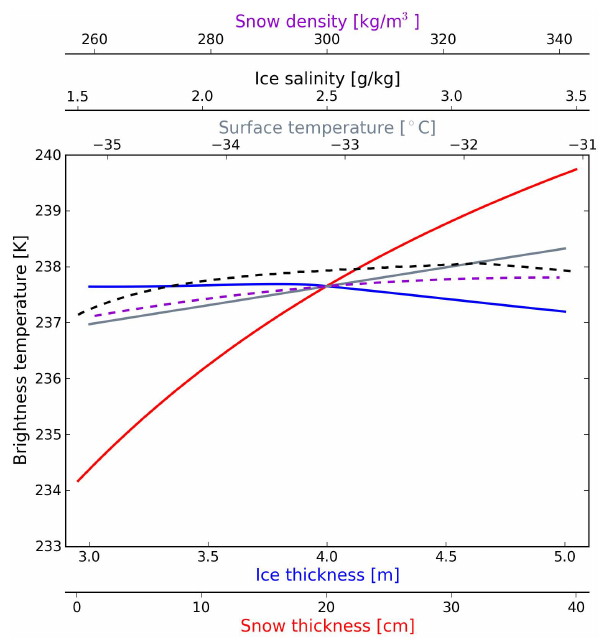
Fig. 3. Horizontally polarised brightness temperature (incidence an- gle θ =45 ◦ ) as it varies with ice thickness, snow thickness, sur- face temperature, ice salinity, or snow density, respectively. The as- sumed values, the variation ranges, and the corresponding changes in brightness temperature are given in Table